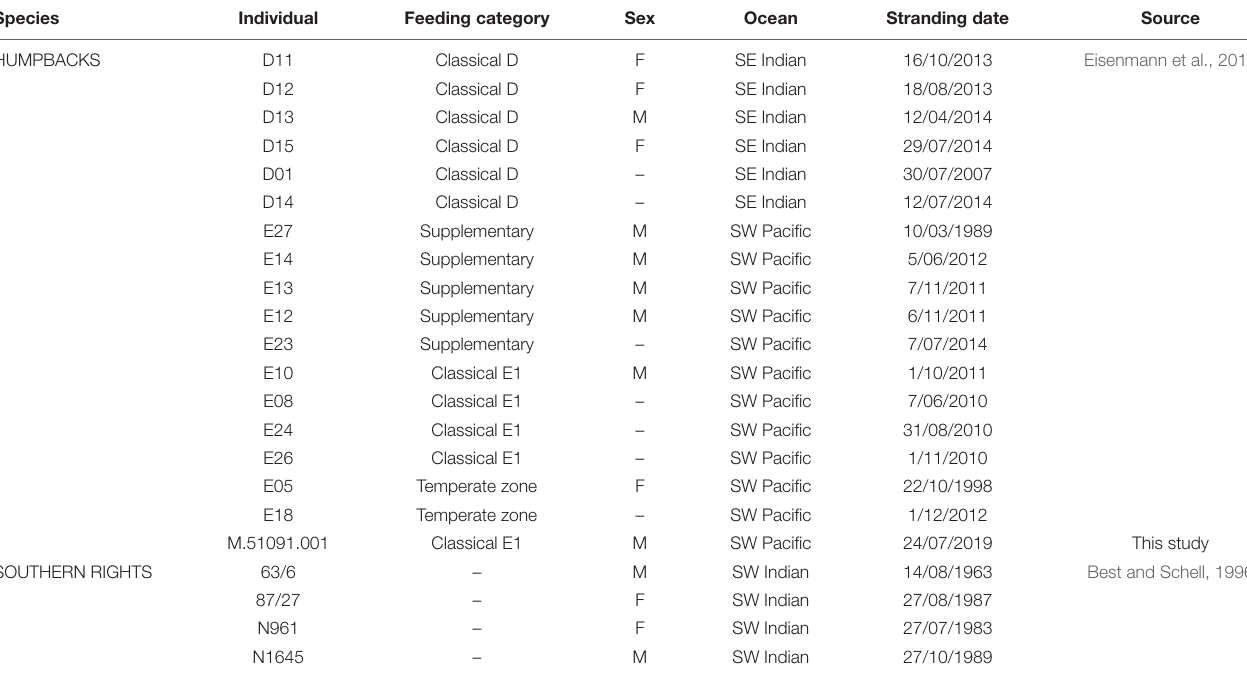
TABLE 1 | Biological information for individuals within this study, and source identifying where data was extracted (all but one individual that was opportunistically sampled by the Australian Museum). Species